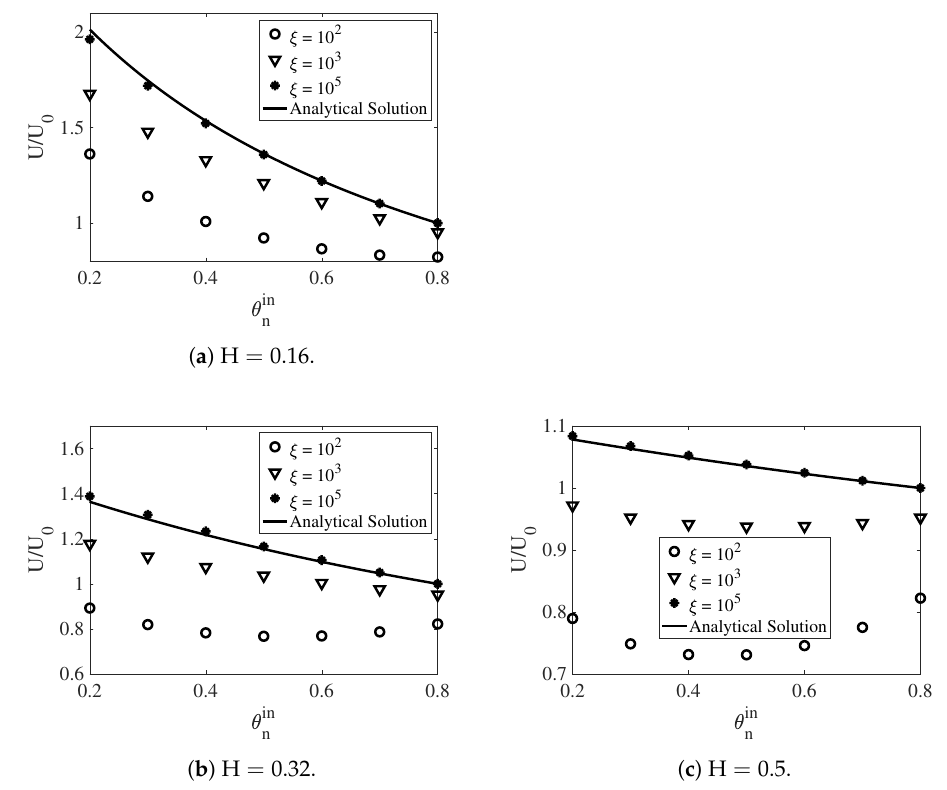
Figure 14. The scaled swimming speed vs. θ i n n for different H and ξ . β = 0.25 and θ o ut n = 0.8. The analytical solutions are from